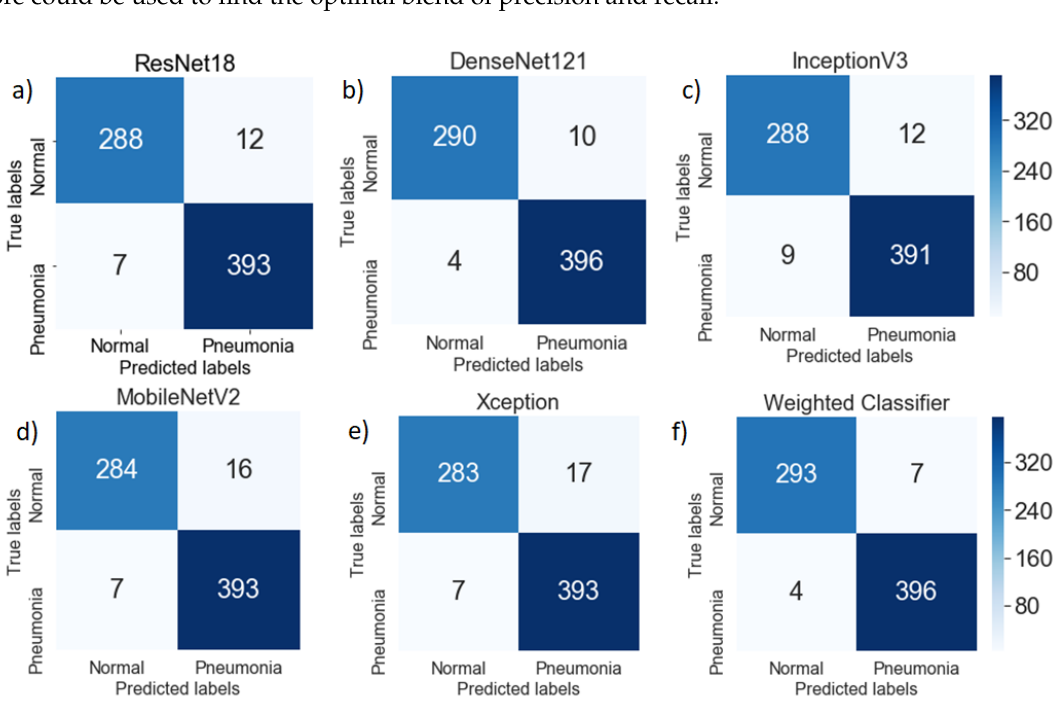
Figure 9. Confusion matrix for ( a ) ResNet18, ( b ) DenseNet121, ( c ) InceptionV3, ( d ) MobileNetV2, ( e ) Xception, and ( f ) Weighted Classifier architectures and the weighted classifier over the testing dataset. False positives were greater than the false negatives for all the